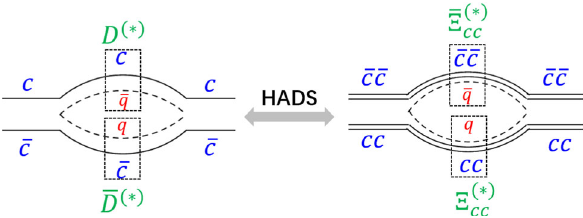
Fig. 2 Left: the two charmed meson channel heavily affects the mass spectra of charmonia close to their mass thresholds. Right: HADS implies that the two doubly charmed baryon channel could also affect the mass spectra of fully charmed tetraquark states close to their mass thresholds